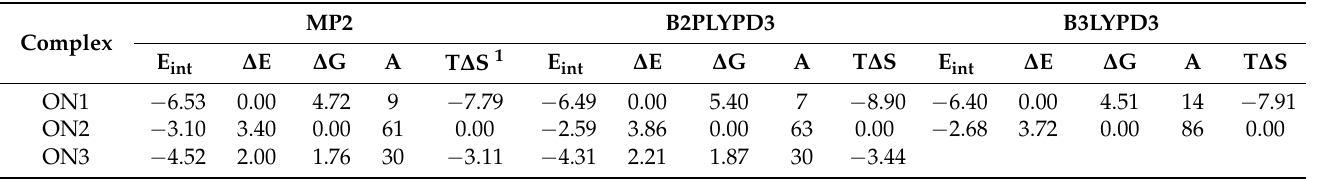
Table 2. BSSE corrected interaction energies E int , relative energies ∆ E, relative Gibbs free energies ∆ G (kJ mol − 1 ), abundance at 298 K A (%) and entropic contributions at 298 K T ∆ S (kJ mol − 1 ) of the HNCO · · · N 2 complexes of the 1:1 stoichiometry calculated at MP2, B2PLYPD3 and B3LYPD3 levels with the